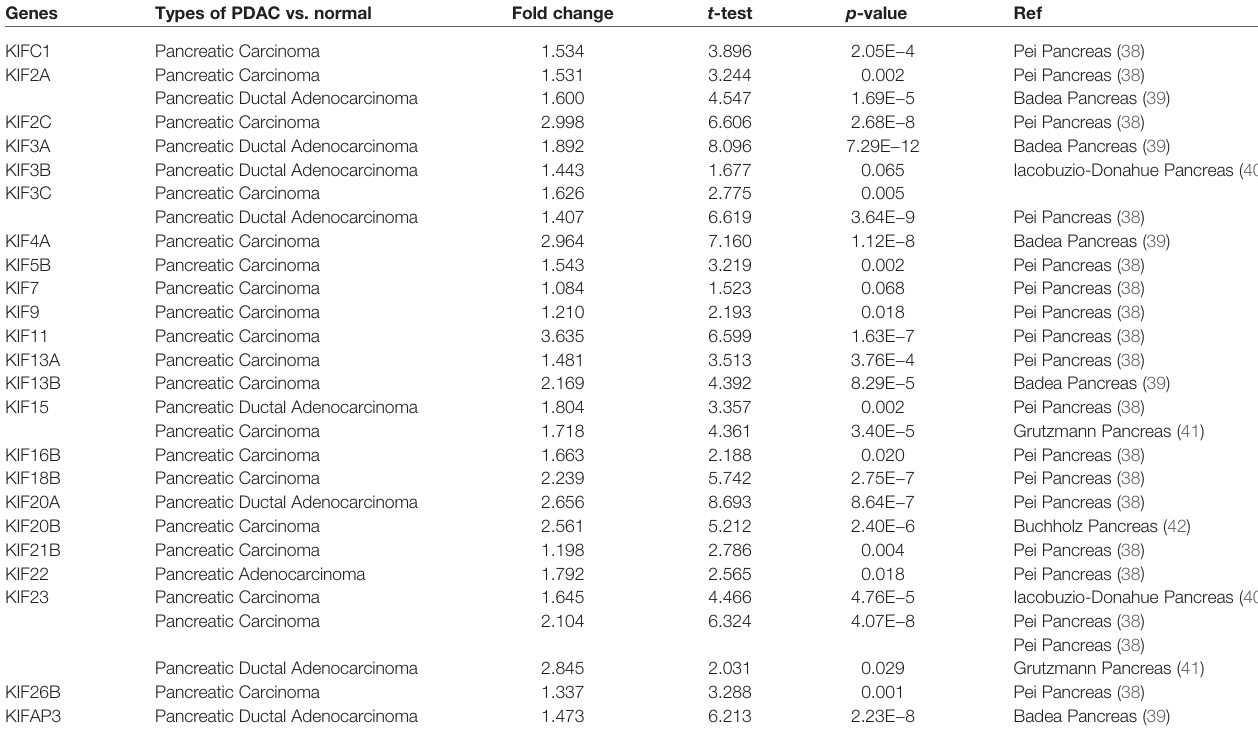
TABLE 1 | The signi fi cant fold changes of KIFs expression in transcription level between different types of PDAC and normal pancreatic tissues (Oncomine). Genes Types of PDAC vs. normal Fold change t -test p -value Ref